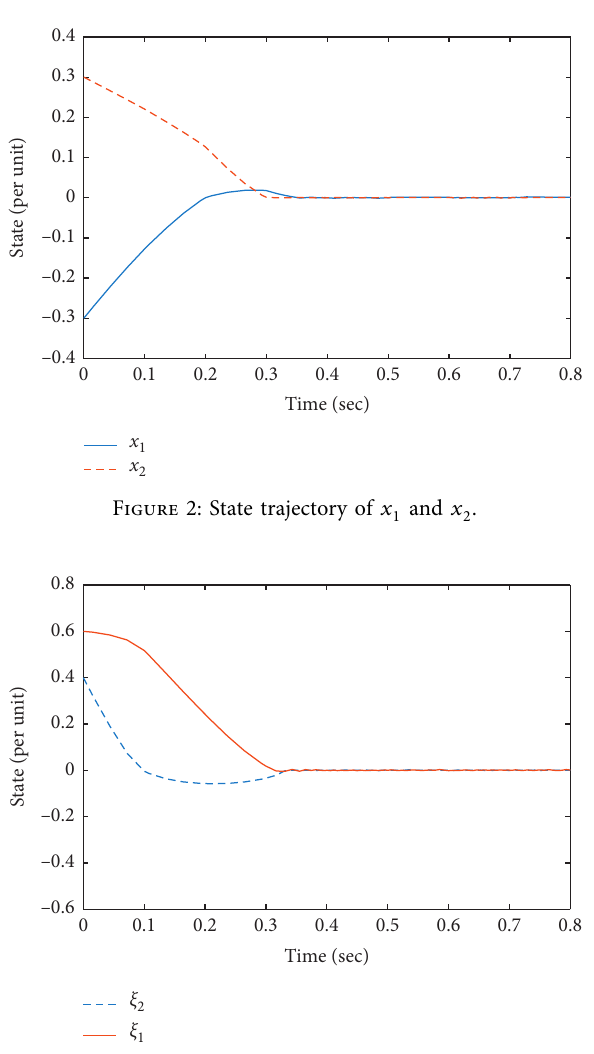
Figure 3: State trajectory of ξ